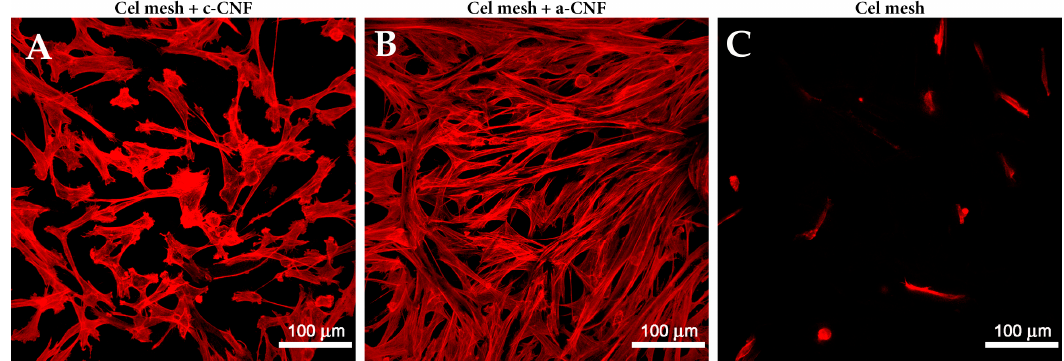
Figure 2. Morphology of human dermal fibroblasts on day 4 after seeding on a cellulose mesh modified with cationic cellulose nanofibers ( A ), with anionic cellulose nanofibers ( B ), and on pristine cellulose mesh ( C ). The cells were stained with phalloidine conjugated with TRITC (stains F-actin, red fluorescence). Leica TCS SPE DM2500 confocal microscope (Leica Microsystems, Wetzlar, Germany), obj. 20 × /1.15 NA